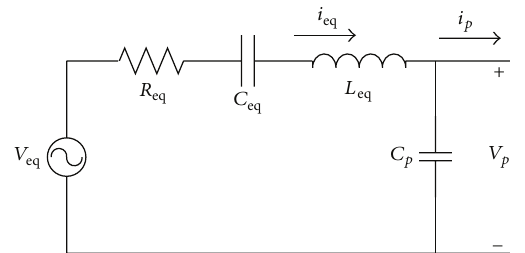
Figure 3: Equivalent circuit model of the harvesting structure.